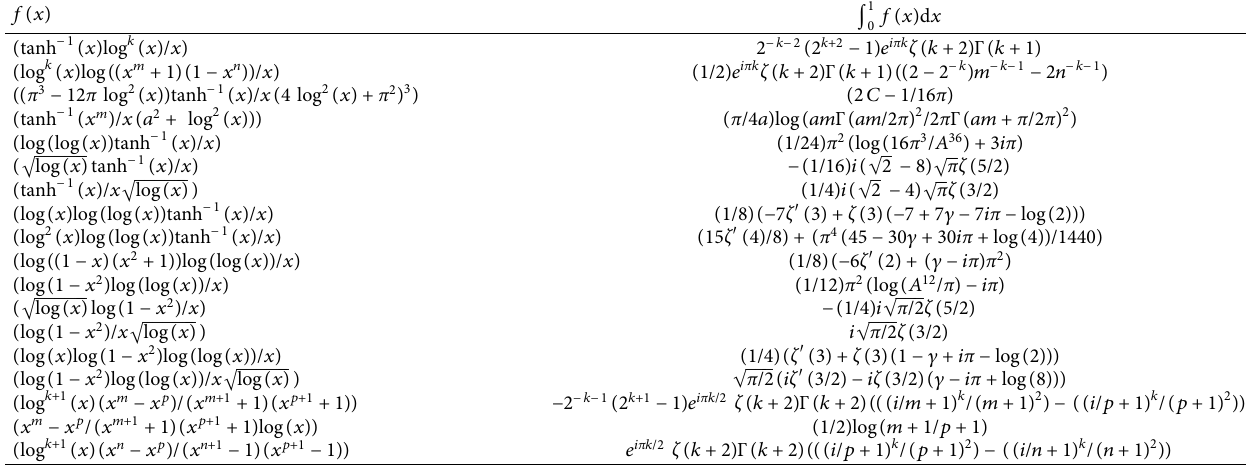
Table 1: Table of definite